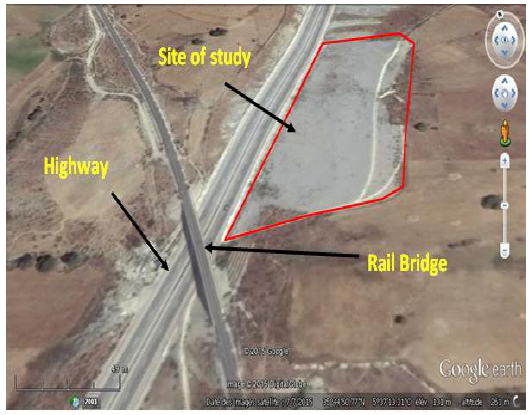
Figure 1. Location of the study area Digital terrain models (DTM) of the studied site was built from topographical surveys, and then the slope and